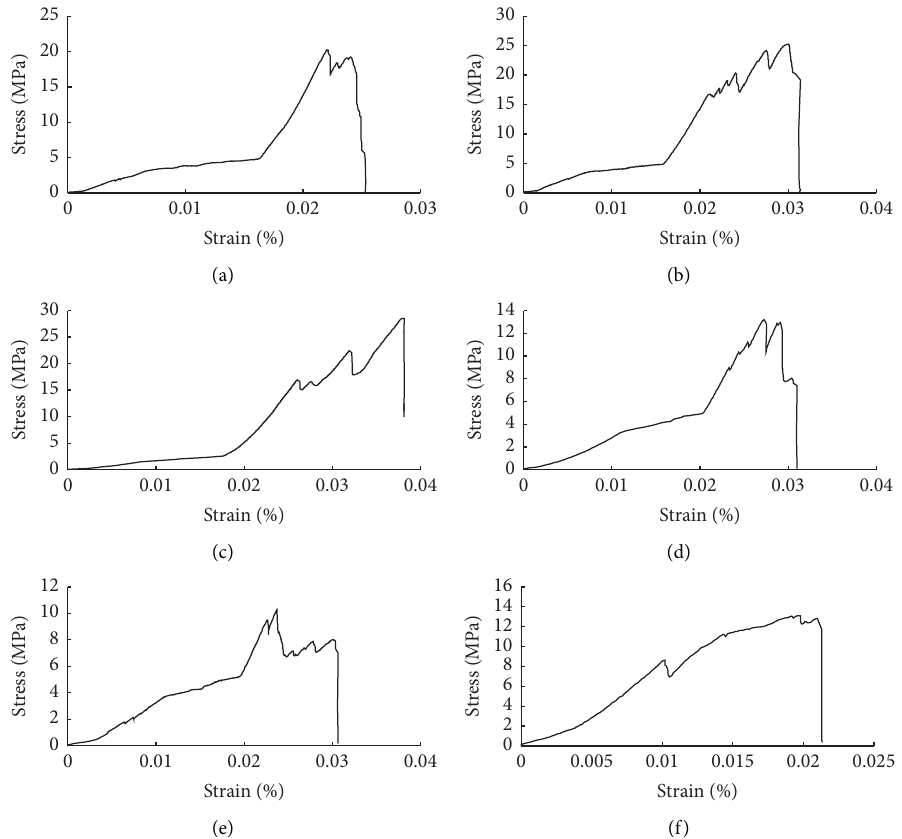
Figure 3: Stress-strain curves of the coal and rock specimens under different loading rates. (a) C1 sandstone with a loading rate of 0.005mm/s. (b) C6 sandstone with a loading rate of 0.01 mm/s. (c) C10 sandstone with a loading rate of 0.05mm/s. (d) A7 coal with a loading rate of 0.01mm/s. (e) A3 coal with a loading rate of 0.005mm/s. (f) A11 coal with a loading rate of